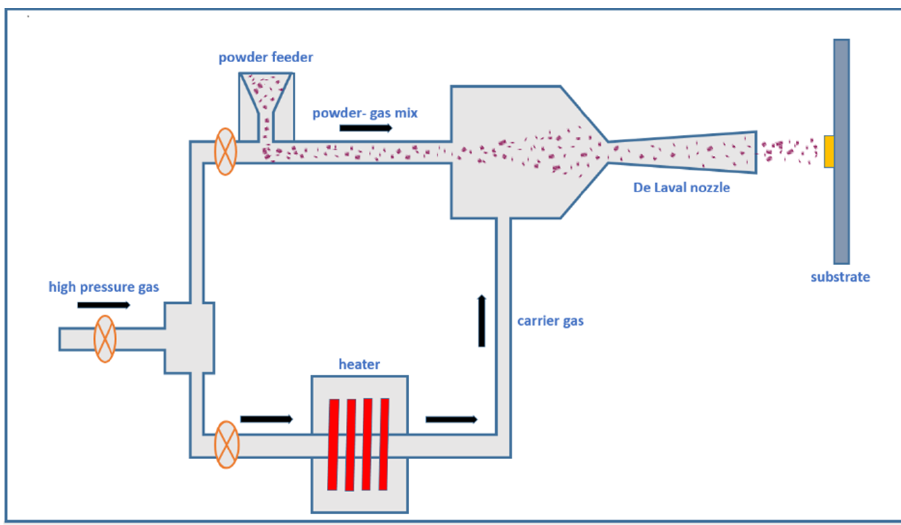
Figure 3. The high-pressure cold spray process.